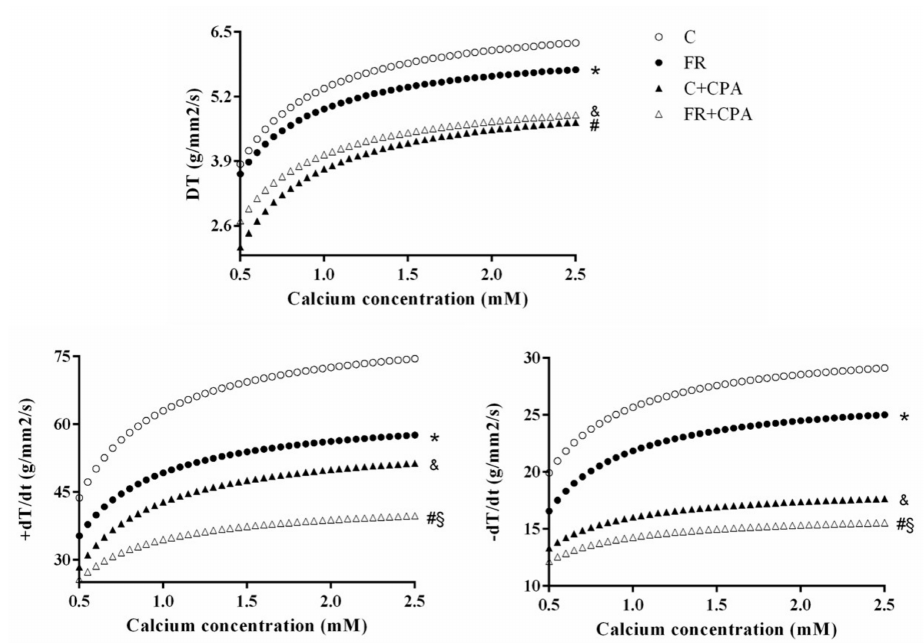
Figure 1. Food restriction (FR) animals presented altered functional responses in the papillary muscle assay in the following parameters: ( A ) developed tension (DT), ( B ) positive tension derivative ( + dT / dt), and ( C ) negative tension derivative ( − dT / dt) C: control group. CPA: Cyclopiazonic acid. C + CPA: control submitted to CPA; FR + CPA: food restriction submitted to CPA. Data presented as mean ± standard deviation. Minimum squares technique complemented with the comparative test of average profiles of responses. p < 0.05; * C vs. FR; § C + CPA vs. FR + CPA; # FR vs. FR + CPA; and & C vs. C + CPA.